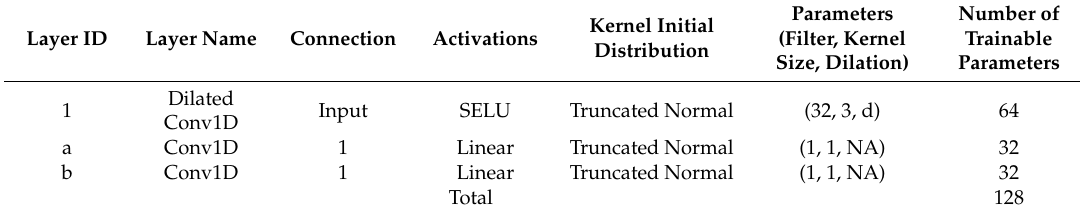
Table 4. SeriesNet